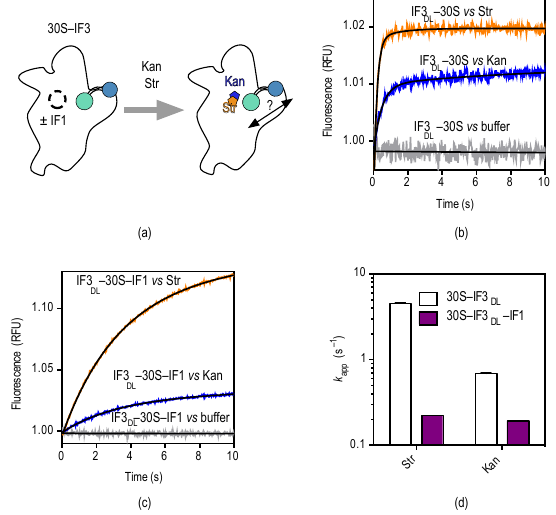
Figure 4. Pre-steady state kinetics of streptomycin and kanamycin binding to 30S–IF3 DL complexes. ( a ) Scheme depicting the experimental approach to monitoring conformational effects as a function of streptomycin (orange) and kanamycin (blue); ( b ) time courses of 30S–IF3 DL (0.1 µM) interacting with each aminoglycoside; colors are as in ( a ). The trace for buffer control indicates no dissociation of IF3 DL during rapid mixing in the stopped-flow apparatus. See Figure S3 for controls in the absence of fluorescence acceptor. ( c ) Time courses of streptomycin and kanamycin binding to 30S–IF3 DL –IF1 (0.1 µM). Smooth lines indicate fits by non-linear regression (Equation (4)). ( d ) Influence of IF1 over the kinetics of IF3 DL conformational changes caused by streptomycin and